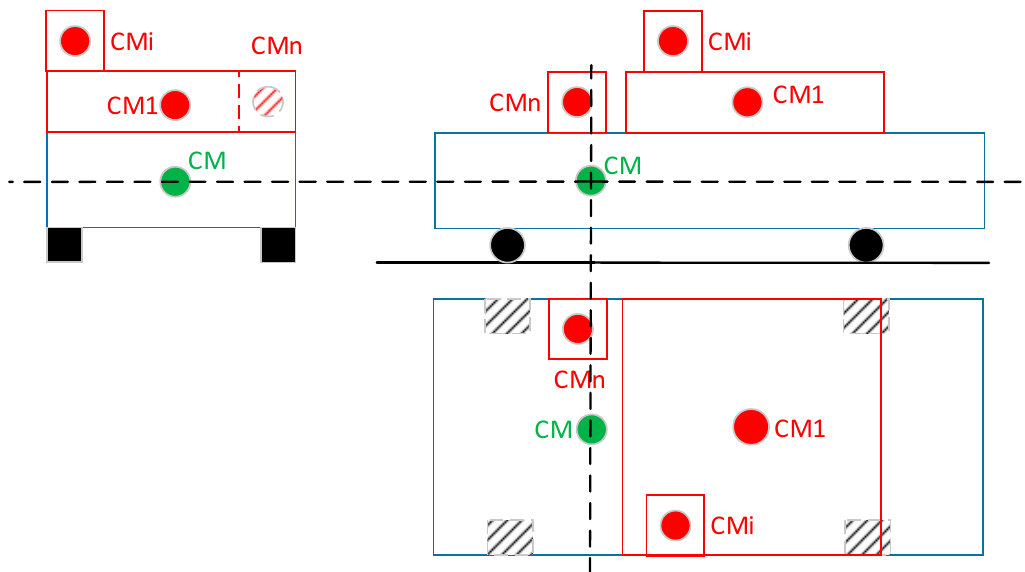
Figure 11. AGV diagram to obtain the position of the AGV center of mass.